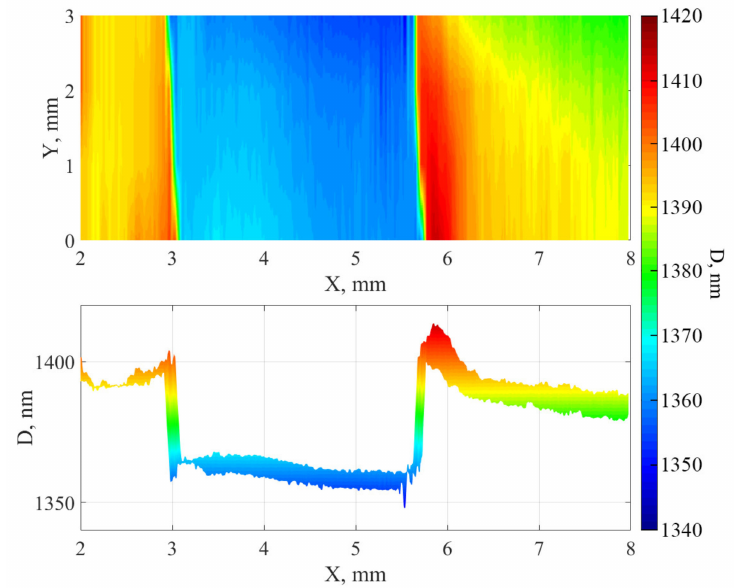
Figure 7. Principal map of the distribution of thicknesses of the aluminum nitride film on Sitall. Top view ( top ) and cross-section of the film ( bottom ).